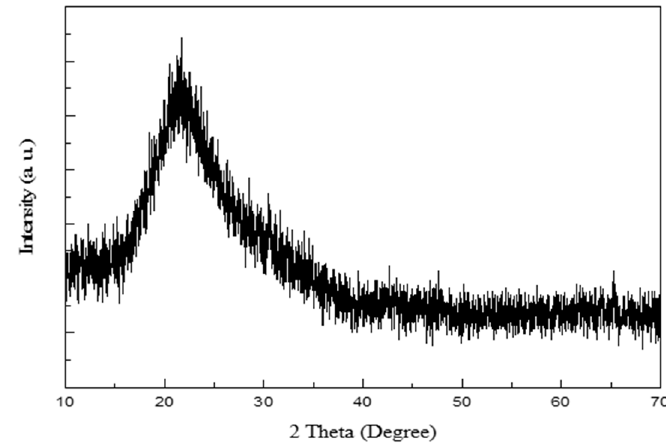
Figure 2. XRD pattern of the rice husk ash obtained through calcination of rice husk at 600 °C.